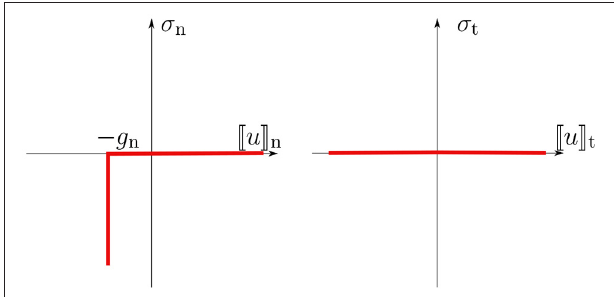
FIGURE 2 | Constitutive relations for the unilateral frictionless contact considered.